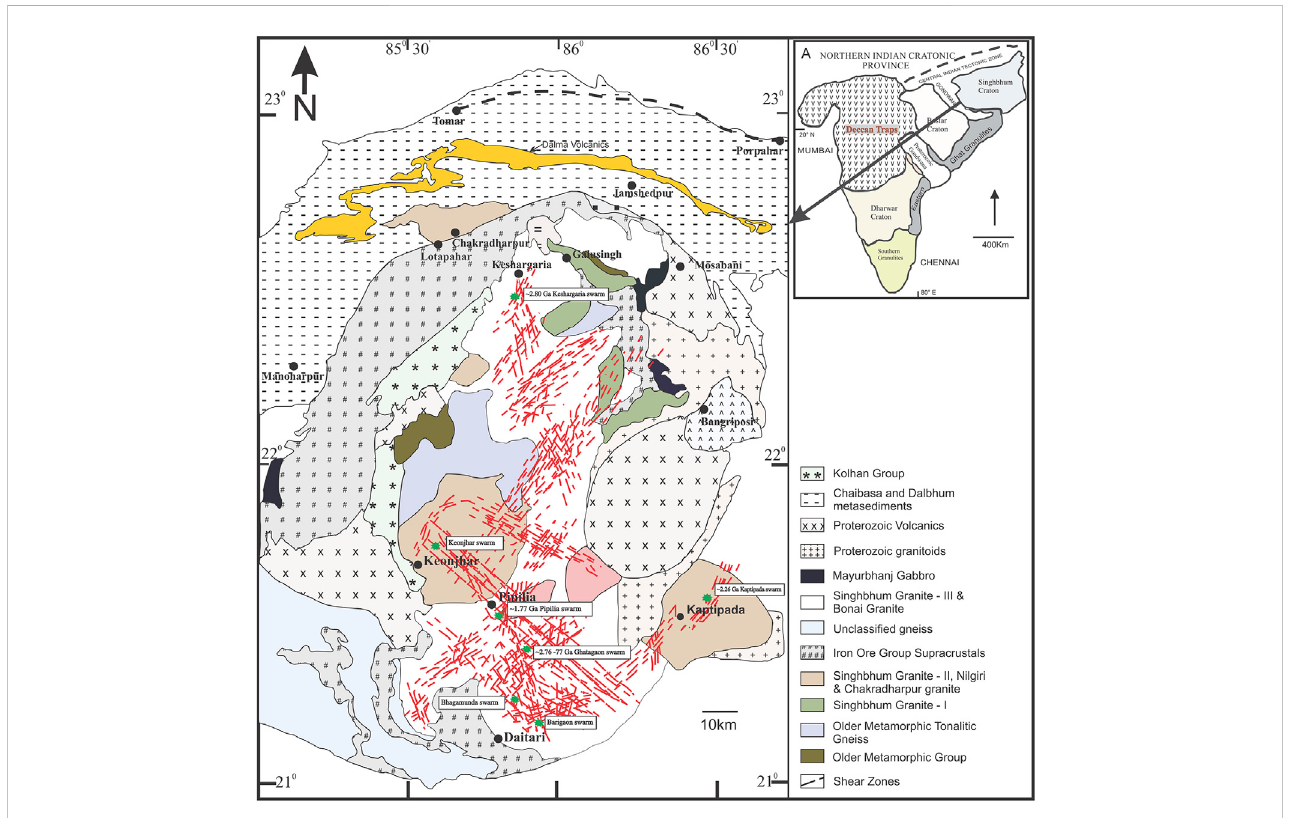
FIGURE 1 Generalized geological map of the Singhbhum craton showing the distribution of major dyke swarms (modi fi ed after Kumar et al., 2017; Srivastava et al., 2019).